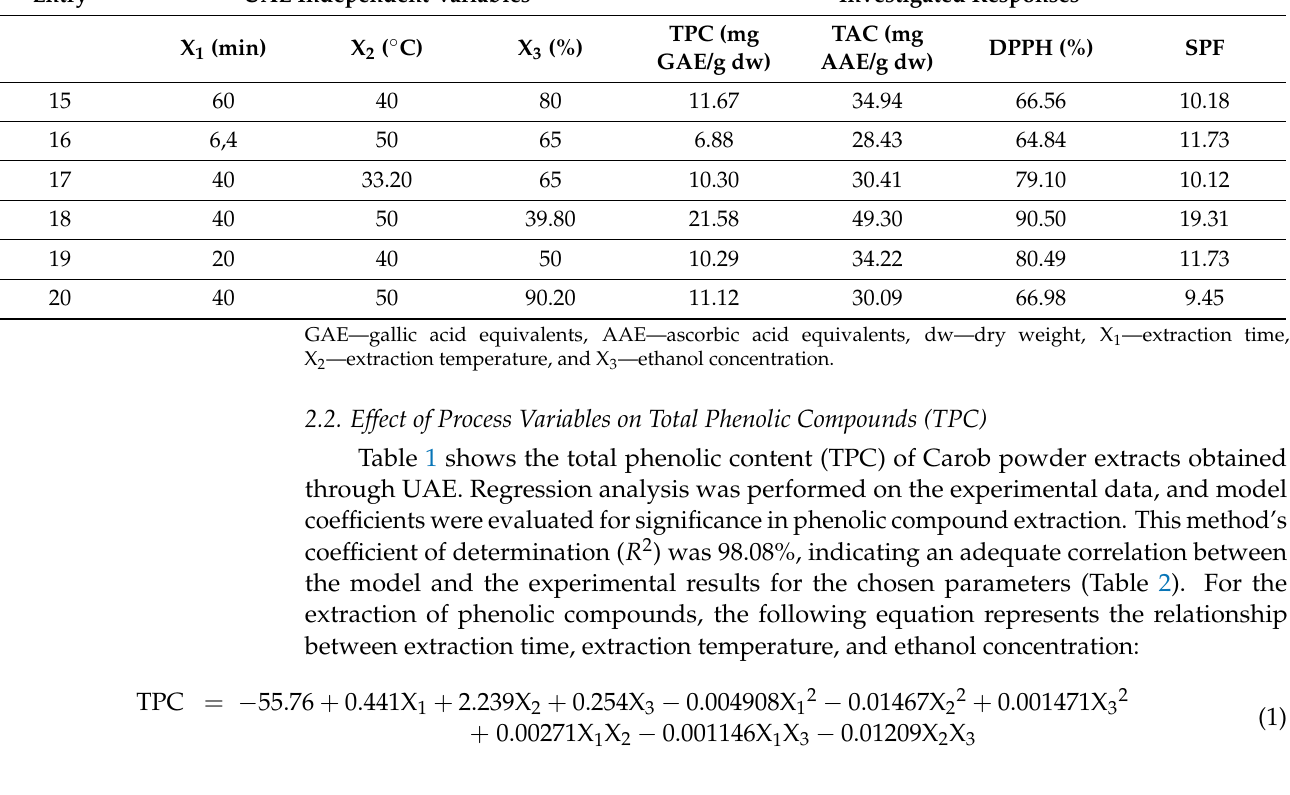
Table 2. ANOVA for evaluation of the total phenolic content